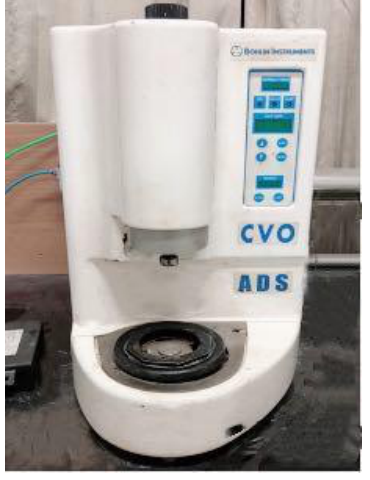
Figure 4. Dynamic shear rheometer.